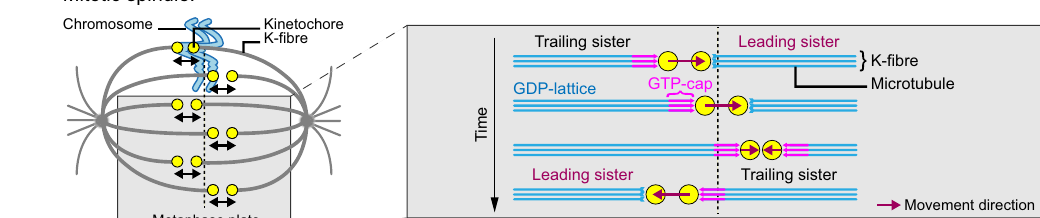
Based on structural data the GDP-tubulin lattice and the GTP- tubulin cap are thought to have different conformational states that are coupled to the nucleotide hydrolysis cycle 5,12,13 . Due to their preferential binding to GTP-tubulin the End-Binding (EB) proteins EB1 and EB3 bind the GTP-cap, while imposing a fi rst structural change on the lattice towards the GDP-tubulin conformation 13,14 . In vitro experiments indicate that EB proteins further maintain their